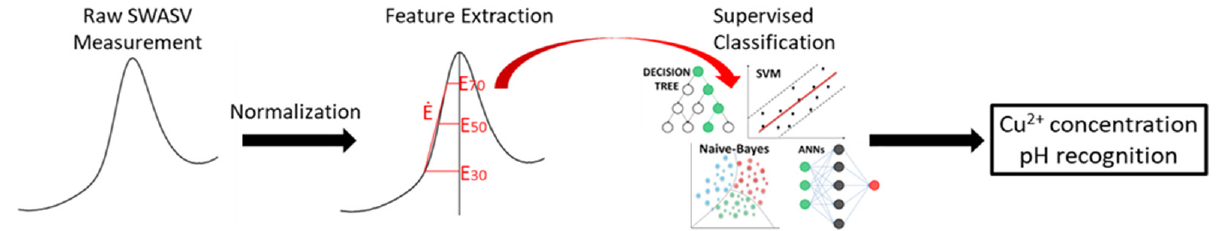
Figure 1. Proposed pipeline for the discrimination of copper ion concentration and pH evaluation.